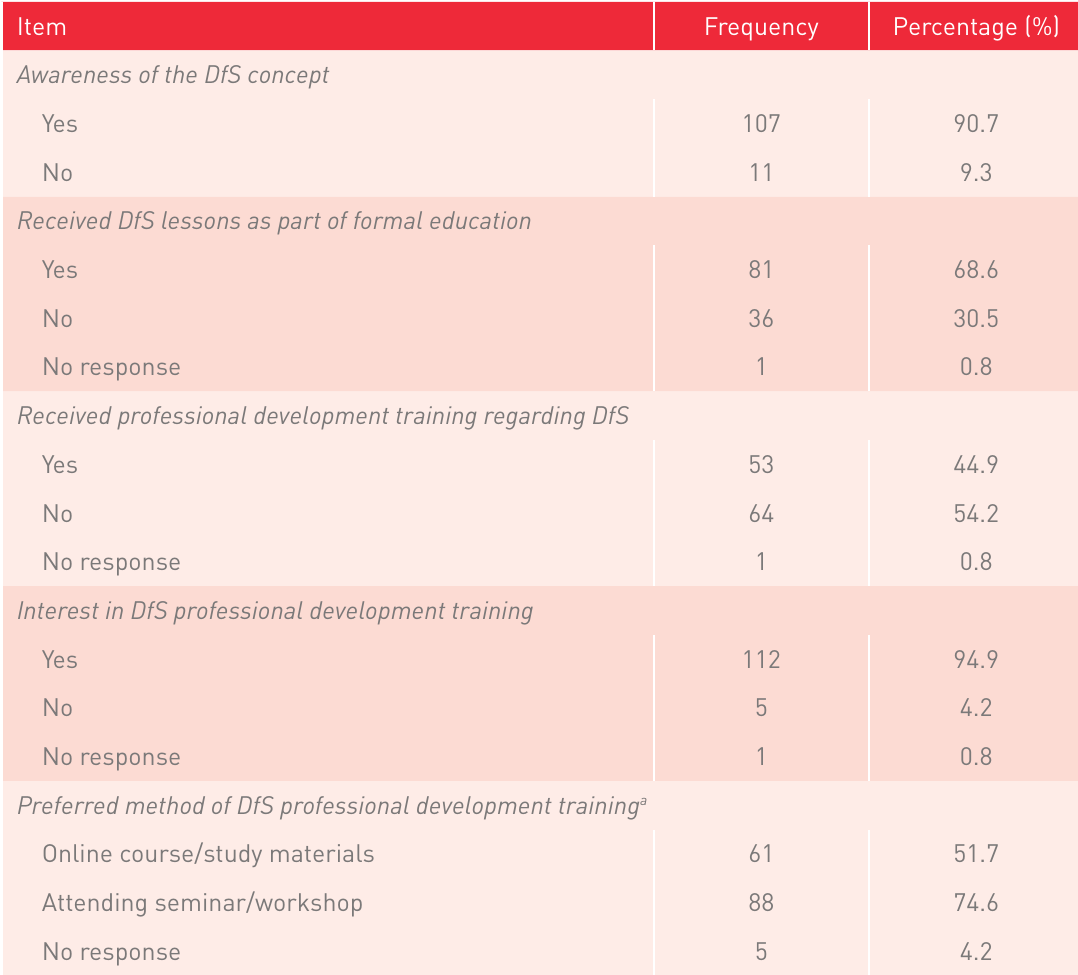
Design for safety awareness, education and professional development training Item Frequency Percentage (%) Awareness of the DfS concept